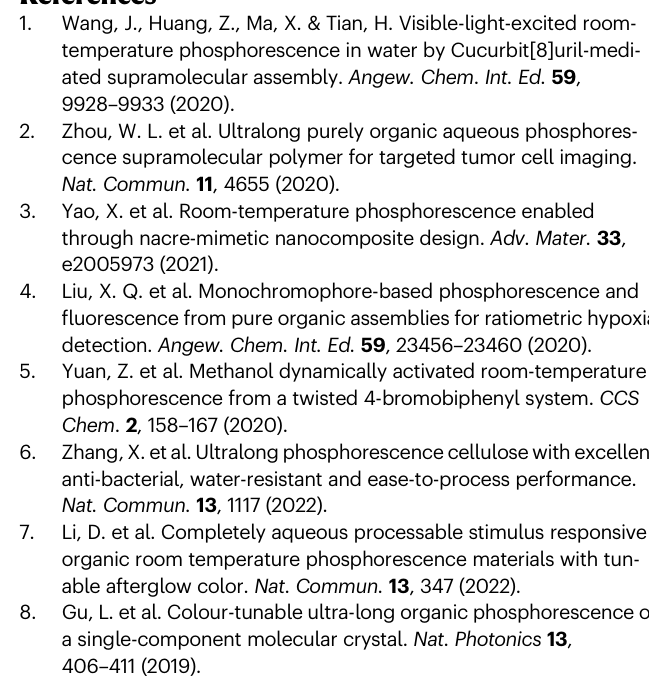
Fig.5|ApplicationsofphotoprogrammablecircularlypolarizedRTPmaterials. a Photographs of the p(phNA-co-BrNpA)-PMMA with light-printing QR code pat- tern in front of a photomask under 365nm light. b Manufacturing process of the anti-counterfeiting patterns and the CPL spectrum of the patterns (top). The pat- tern of “ 8 ” was generated on each material using p(phNA)-PMMA fi rst, and the